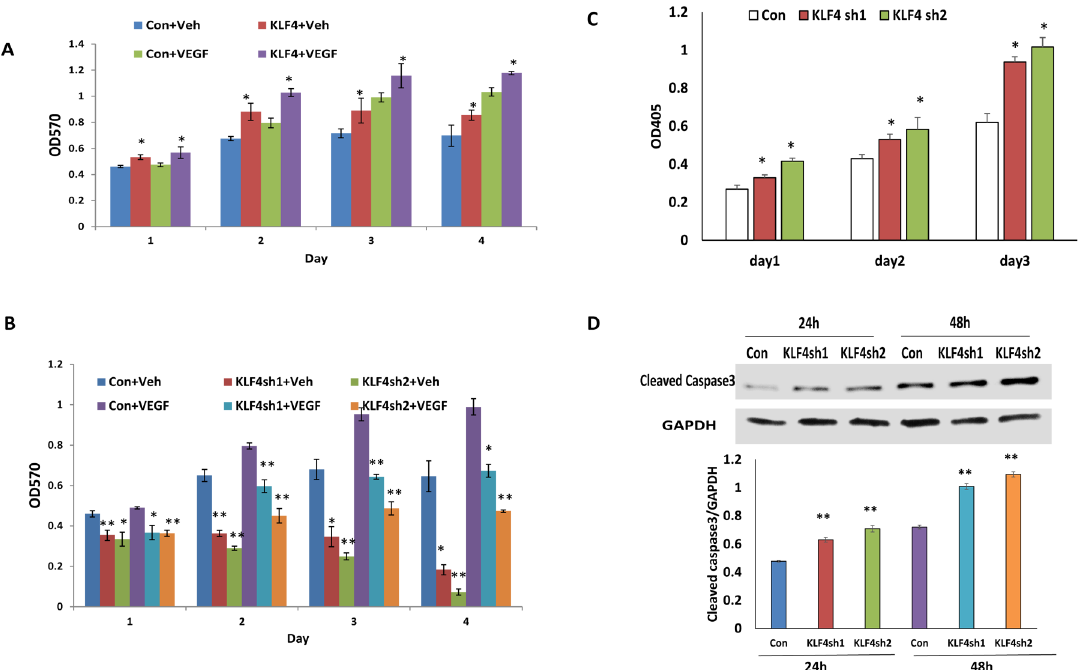
Fig 1. KLF4 promotes VEGF induced cell proliferation. A, B. Cell proliferation was examined at different time points in KLF4 expressing and knocking down HRMECs. Cells were treated with VEGF or vehicle (Veh) following 24h serum-free media culture before measuring cell proliferation using a MTT assay. Significance was observed between KLF4 expressing and control cells with or without VEGF induction. C . Cell apoptosis was examined using ELISA from HRMECs transduced with lentiviral KLF4shRNA1, 2 and Scramble controls. D. One representative Western blot was shown on the active caspase3 expression at indicated time points in KLF4 knockdown and control cells following 12h serum starvation. Significance was compared between KLF4 knockdown and control cells at the indicated time points. Data are presented as mean ± S.E. from 3 independent experiments, ( * p < 0.05, ** p <